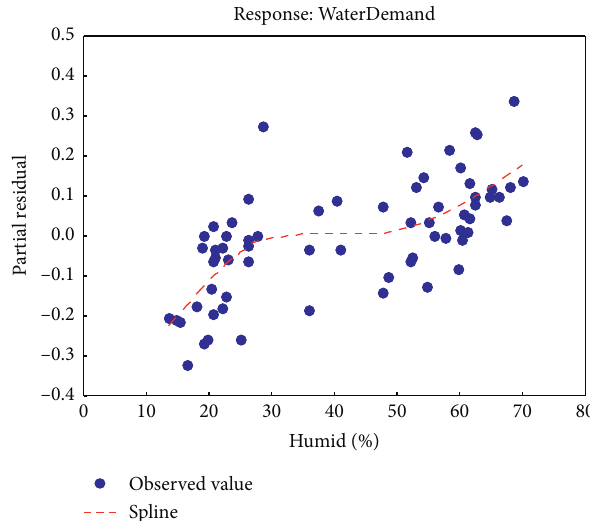
Figure 3: The combined response of the water consumption to relative humidity.